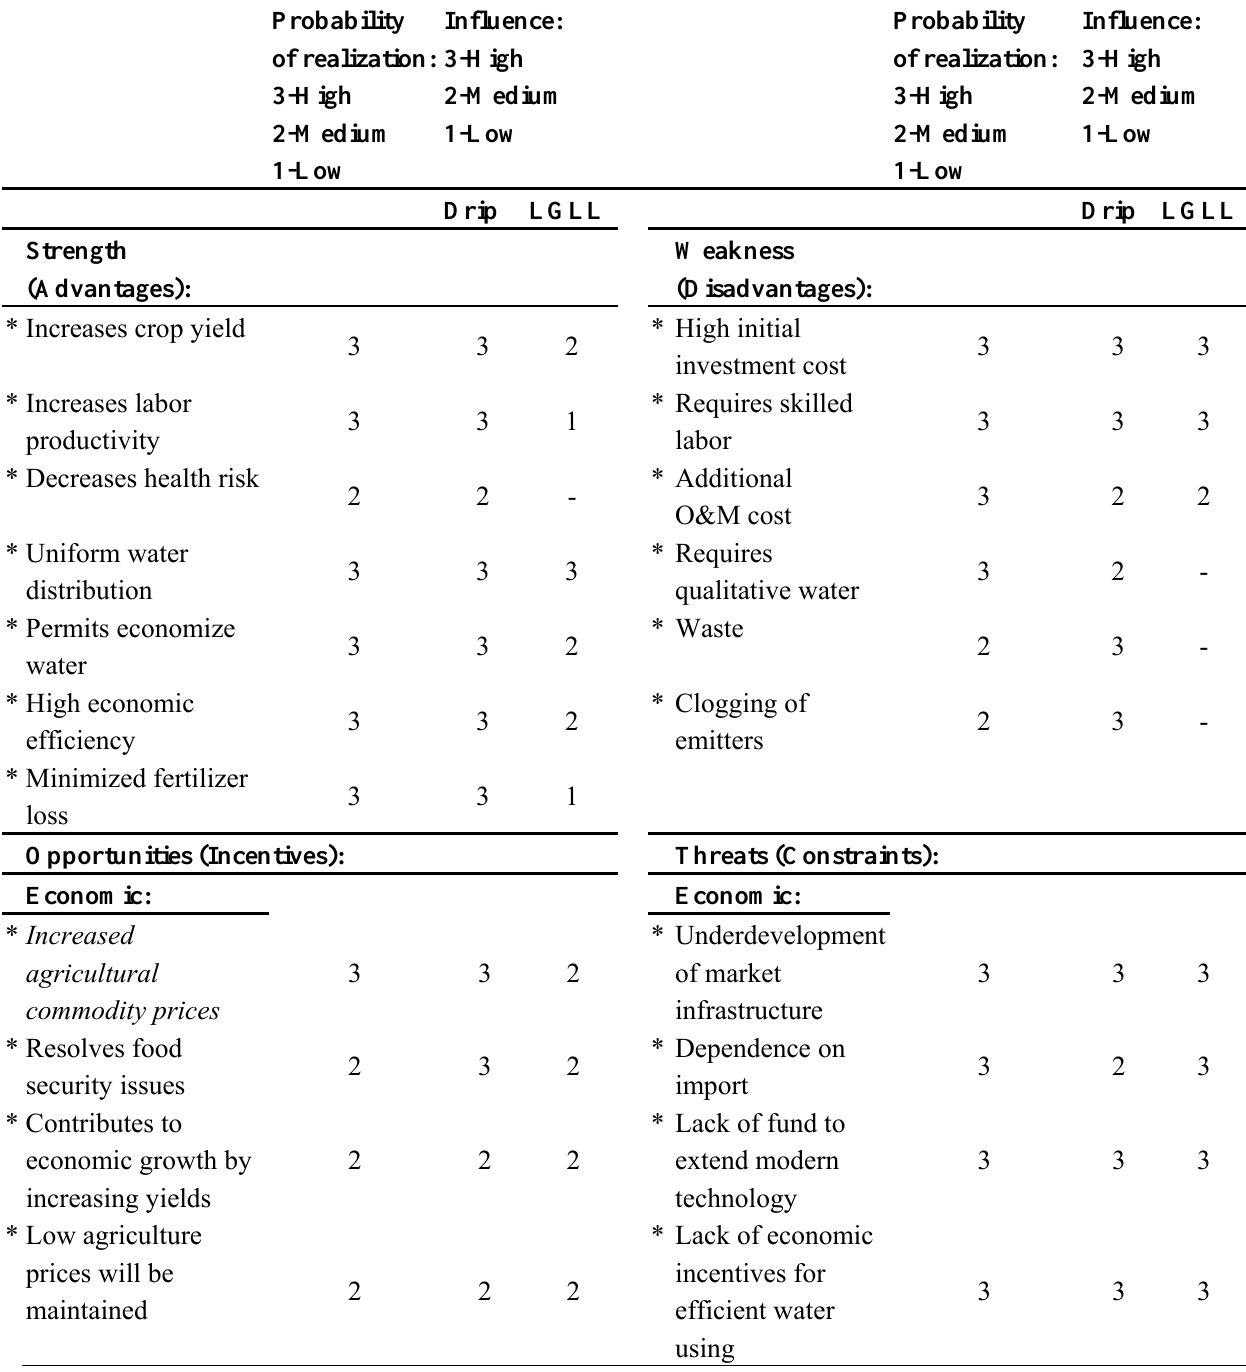
Table 3. SWOT analysis of implementing advanced water-wise